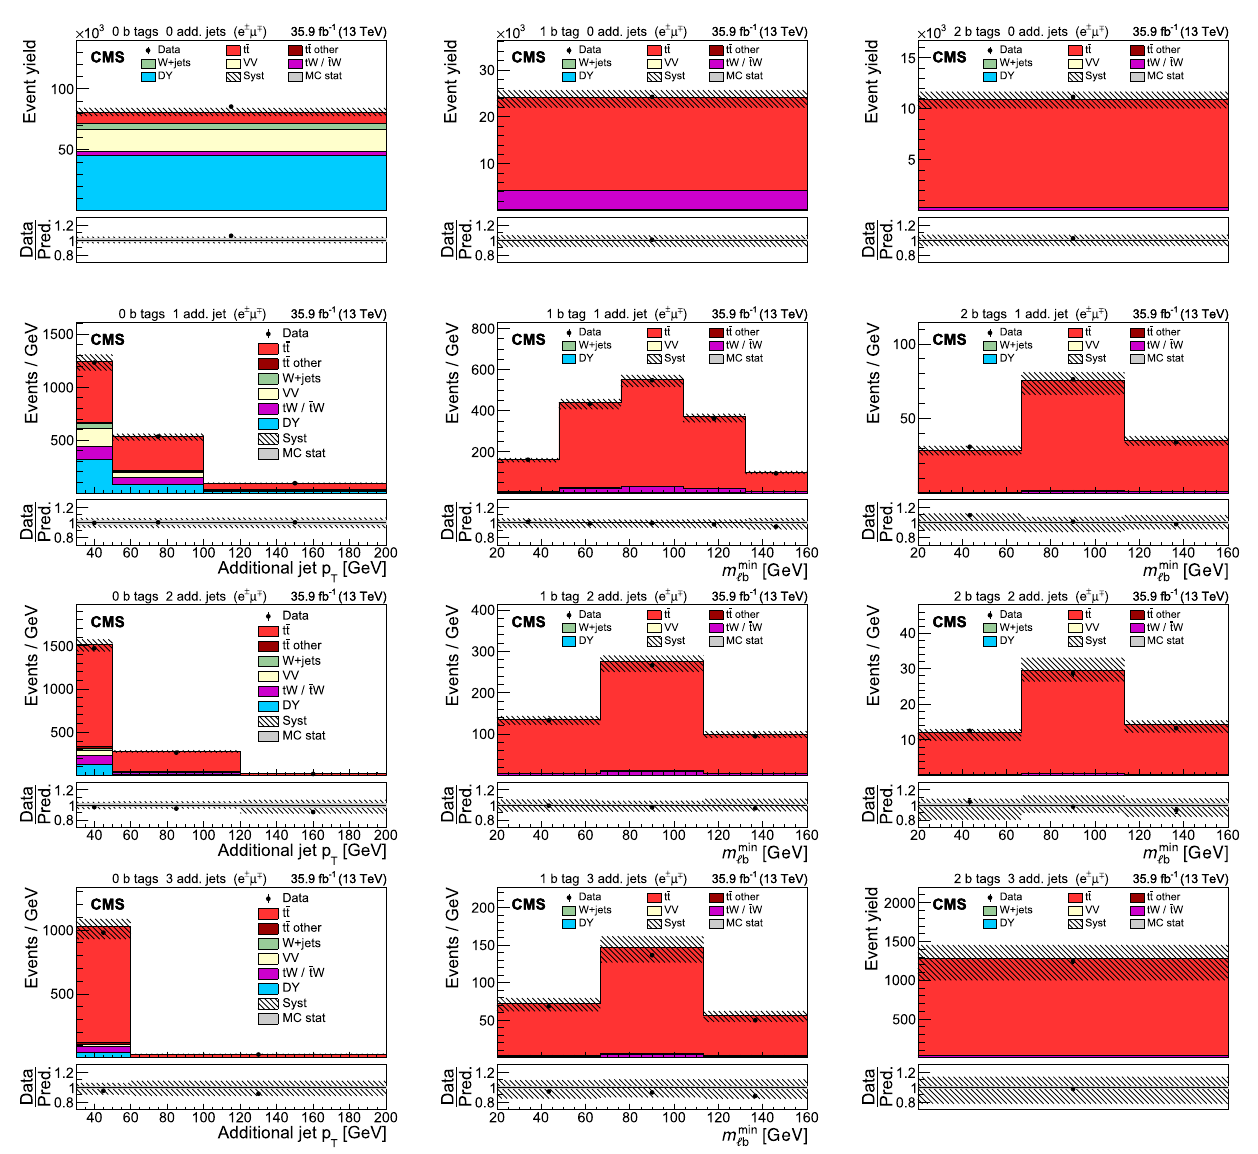
Fig. 8 Comparison of data (points) and pre-fit distributions of the expected signal and backgrounds from simulation (shaded histograms) used in the simultaneous fit of σ tt and m MC t in the e ± μ ∓ channel. In the left column events with zero or three or more b-tagged jets are shown. The middle (right) column shows events with exactly one (two) b-tagged jets. Events with zero, one, two, or three or more additional